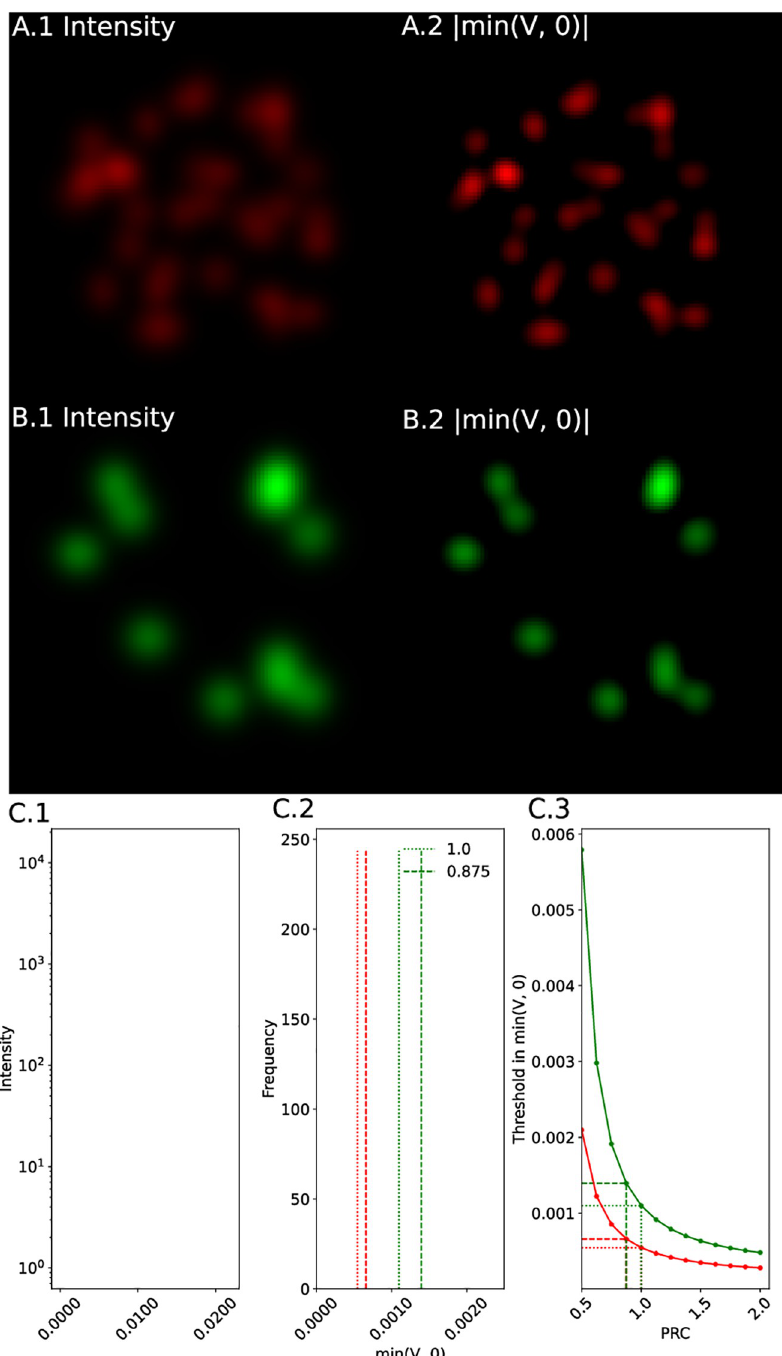
Fig 3. Adaptive thresholding. Kurtosis based thresholding illustrated on two in silico images. A: N = 35, s ¼ 10 þ 5 � r and ðÞ , B: N = 12, s ¼ 15 þ 5 � r and ðÞ , sources randomly placed, with isotropic PSF. A.2 and B.2 show the negative 3 1 Laplacian, and illustrate how it is less susceptible to intensity differences. C.1: The intensity distribution of both images. C.2: The distribution of the Laplacian of both images. C.3: The automatically derived threshold based on kurtosis can be scaled in favor of precision (PRC < 1) or recall (PRC > 1). The plot shows how kurtosis space thresholding follows the different shapes of the distributions.